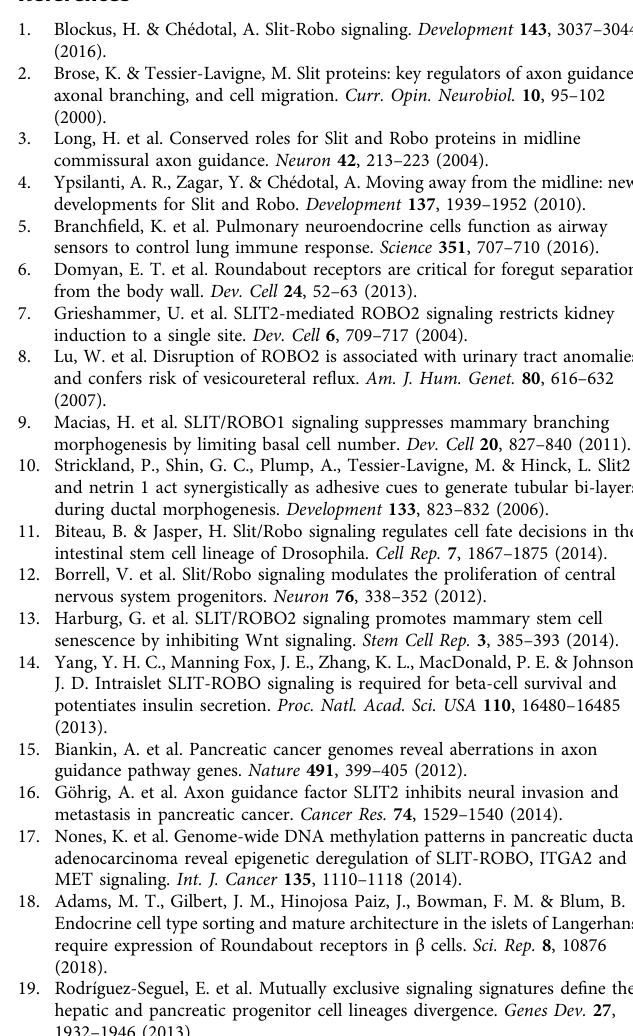
Fig. 7 Robo signalling in fl uences YAP/TEAD transcription activity. a RT-qPCR analysis of indicated genes in E12.5 CTRL and Robo1/2 KO mouse pancreas. Data are represented as relative fold change. Values shown are mean±s.e.m. ( n = 4). * P < 0.05, two-tailed unpaired t -test. b Quanti fi cation of panTEAD fl uorescence intensity in E10.5 CTRL and Robo1/2 KO ventral pancreas normalised to Hoechst intensity and area of epithelium. ( n = 3). ** P <0.01, two-tailed unpaired t -test. c Representative IF images of E10.5 CTRL and Robo1/2 KO ventral pancreas (vp) cryosections stained for Pdx1, Tead and Ecad. Merge and single channels are shown. ( n = 3). d Representative IF images of E10.5 CTRL and Robo1/2 KO dorsal pancreas (dp) cryosections stained for Pdx1, Tead and Ecad. Hoechst (Hoe) was used as nuclear counterstain. ( n = 3). Dashed lines mark pancreatic epithelium ( c , d ). Scale bars, 20 µ m. e Representative IF images higher magni fi cation and a-Yap channel only. Dashed lines mark pancreatic epithelium. Asterisks indicate Pdx1-low cells that are devoid of a-Yap